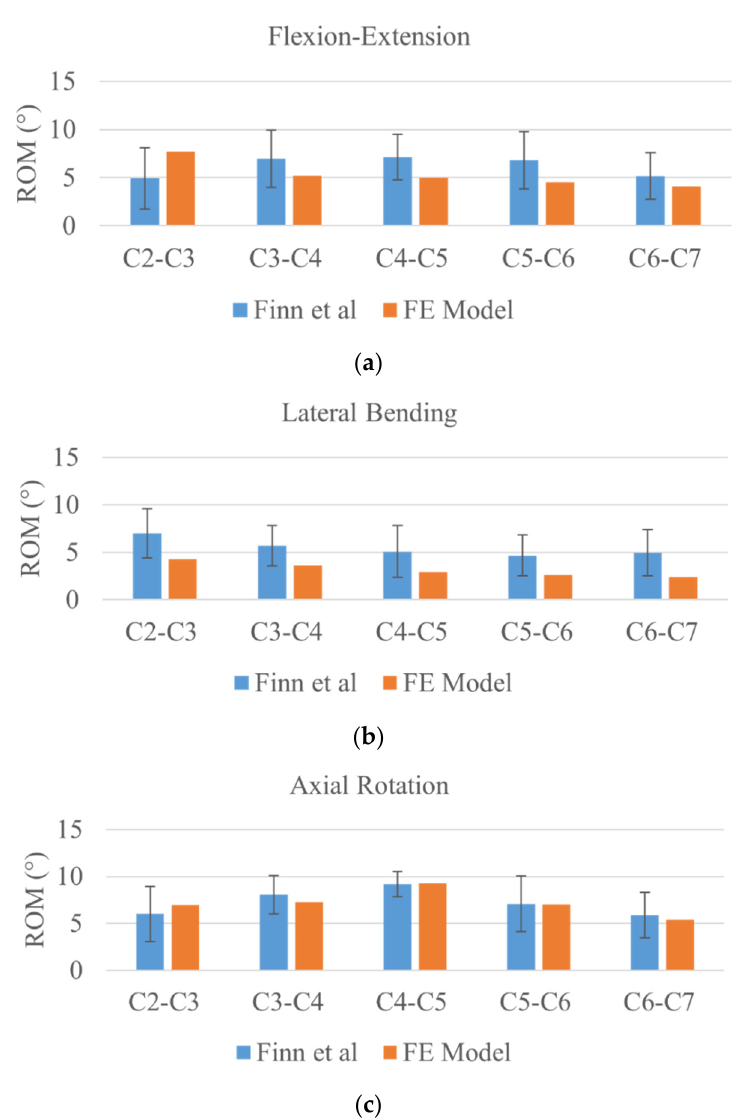
Figure 3. ( a ) Comparison of the flexion-extension motion between the FE model results and the results reported in the literature [25]. ( b ) Comparison of the lateral bending motion between the FE model results and the results reported in the literature [25]. ( c ) Comparison of the axial rotation motion between the FE model results and the results reported in the literature